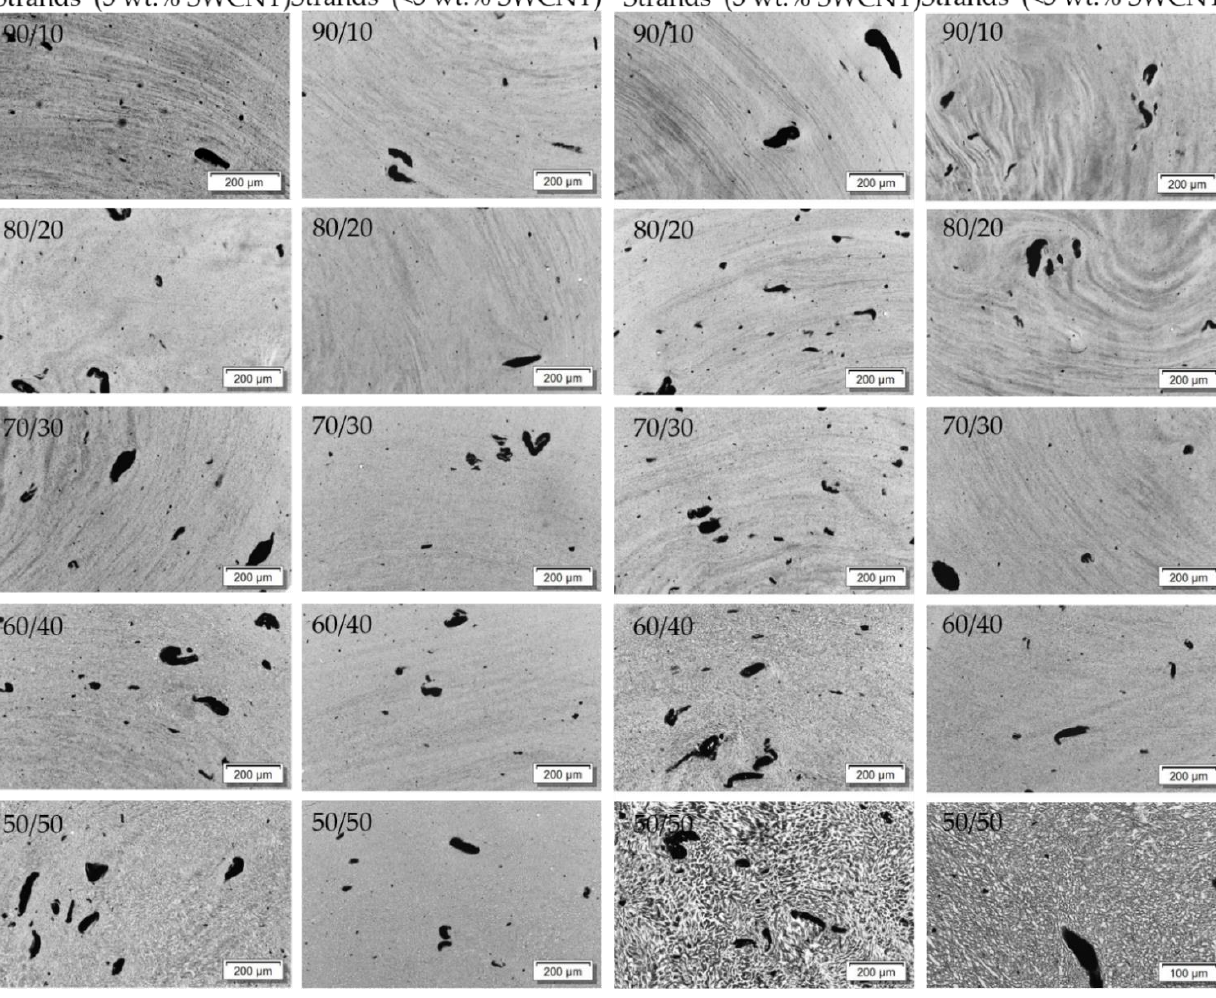
Figure 5. LM images of PA6/SAN and PA6/PMMA blends with different SWCNT contents for set 1 (3 wt.% SWCNT), for set 2 the SWCNT contents are given in Table 1. Table 2. Agglomerate area ratio for PA6/SAN/SWCNT and PA6/PMMA/SWCNT blends for sets 1 and